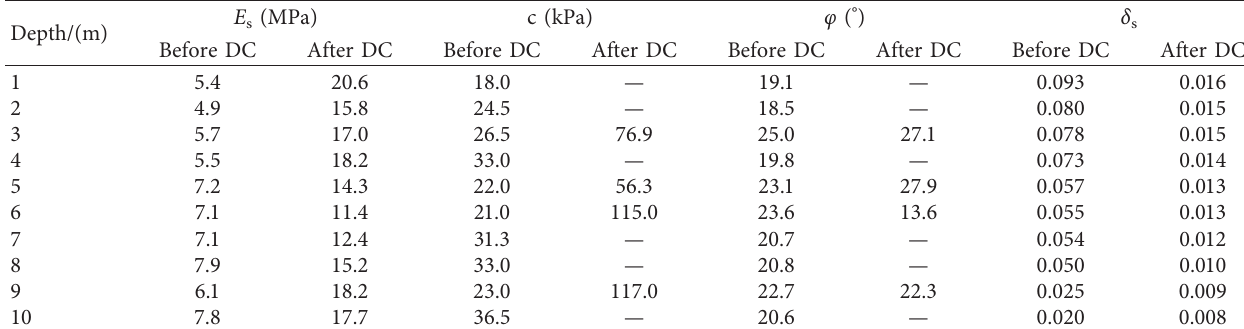
Table 5: Laboratory test results of mechanical parameters of the soil before and after